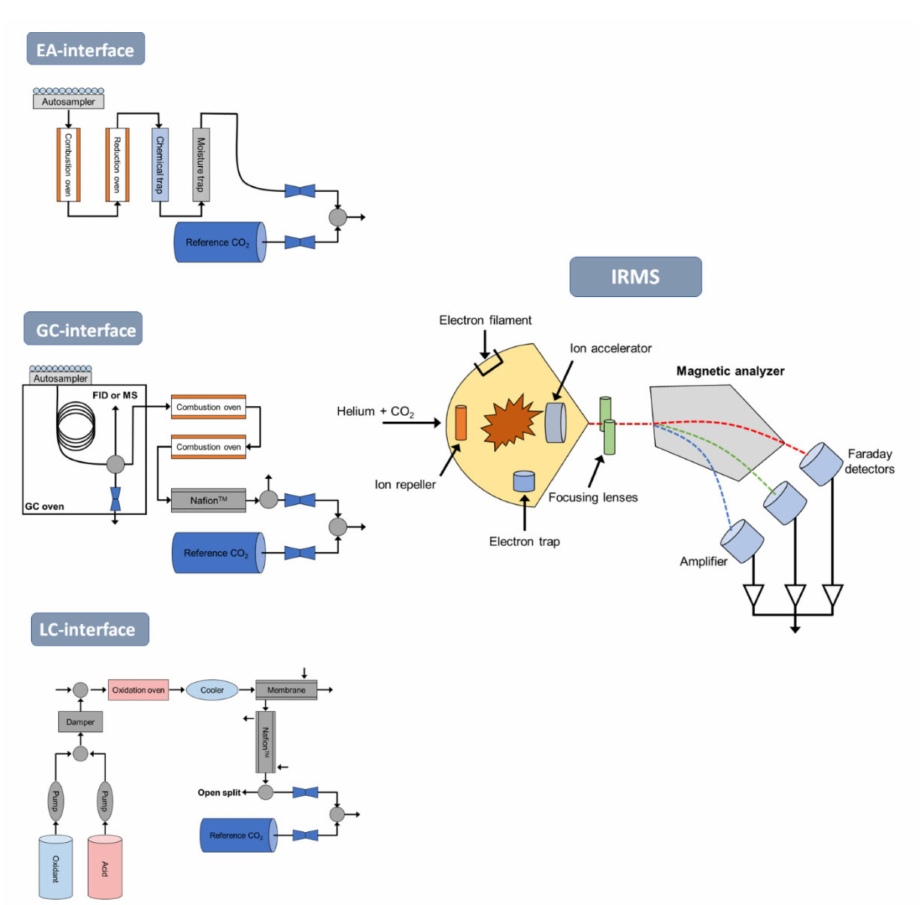
Figure 1. Measurement of isotope ratios by isotope ratio mass spectrometry (IRMS) combined with: (A) Elemental analysis- isotope ratio mass spectrometry (EA-IRMS), in which solid samples are combusted and separated into gases by an elemental analyzer before being introduced into the IRMS. (B) Gas chromatography-combustion-isotope ratio mass spectrometry (GC-C-IRMS), in which samples are injected into a gas chromatograph for separation prior to combustion and introduction into the isotope ratio mass spectrometer, and (C) liquid chromatography-isotope ratio mass spectrometry (LC-IRMS), in which samples are injected into a liquid chromatograph for separation and then flow into an isotope ratio mass spectrometer. Figure was slightly modified from Muccio and Jackson [92] (adapted with a permission from ref. [92]. Copyright 2009, The Royal Society of